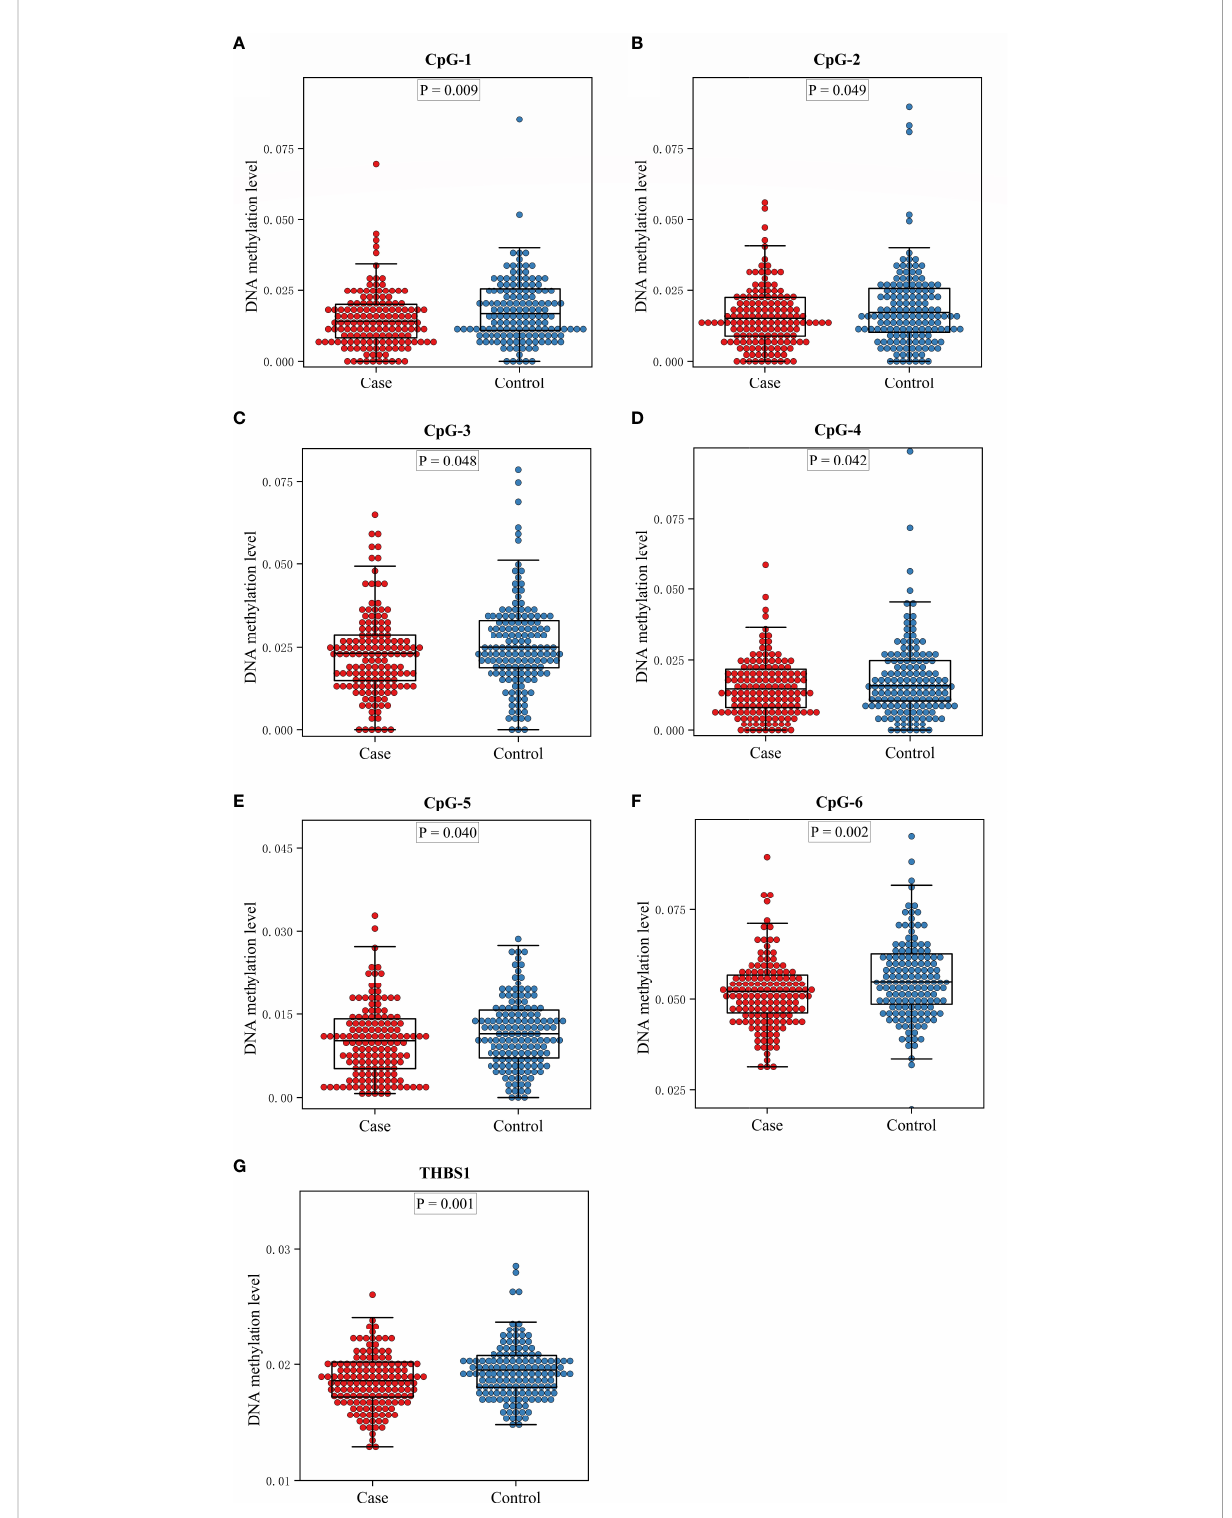
FIGURE 2 The box plots of methylation levels of THBS1 in the case and control groups. (A – F) Methylation levels of six CpG loci with signi fi cant difference in the case and control group. (G) Methylation levels of THBS1 in the case and control